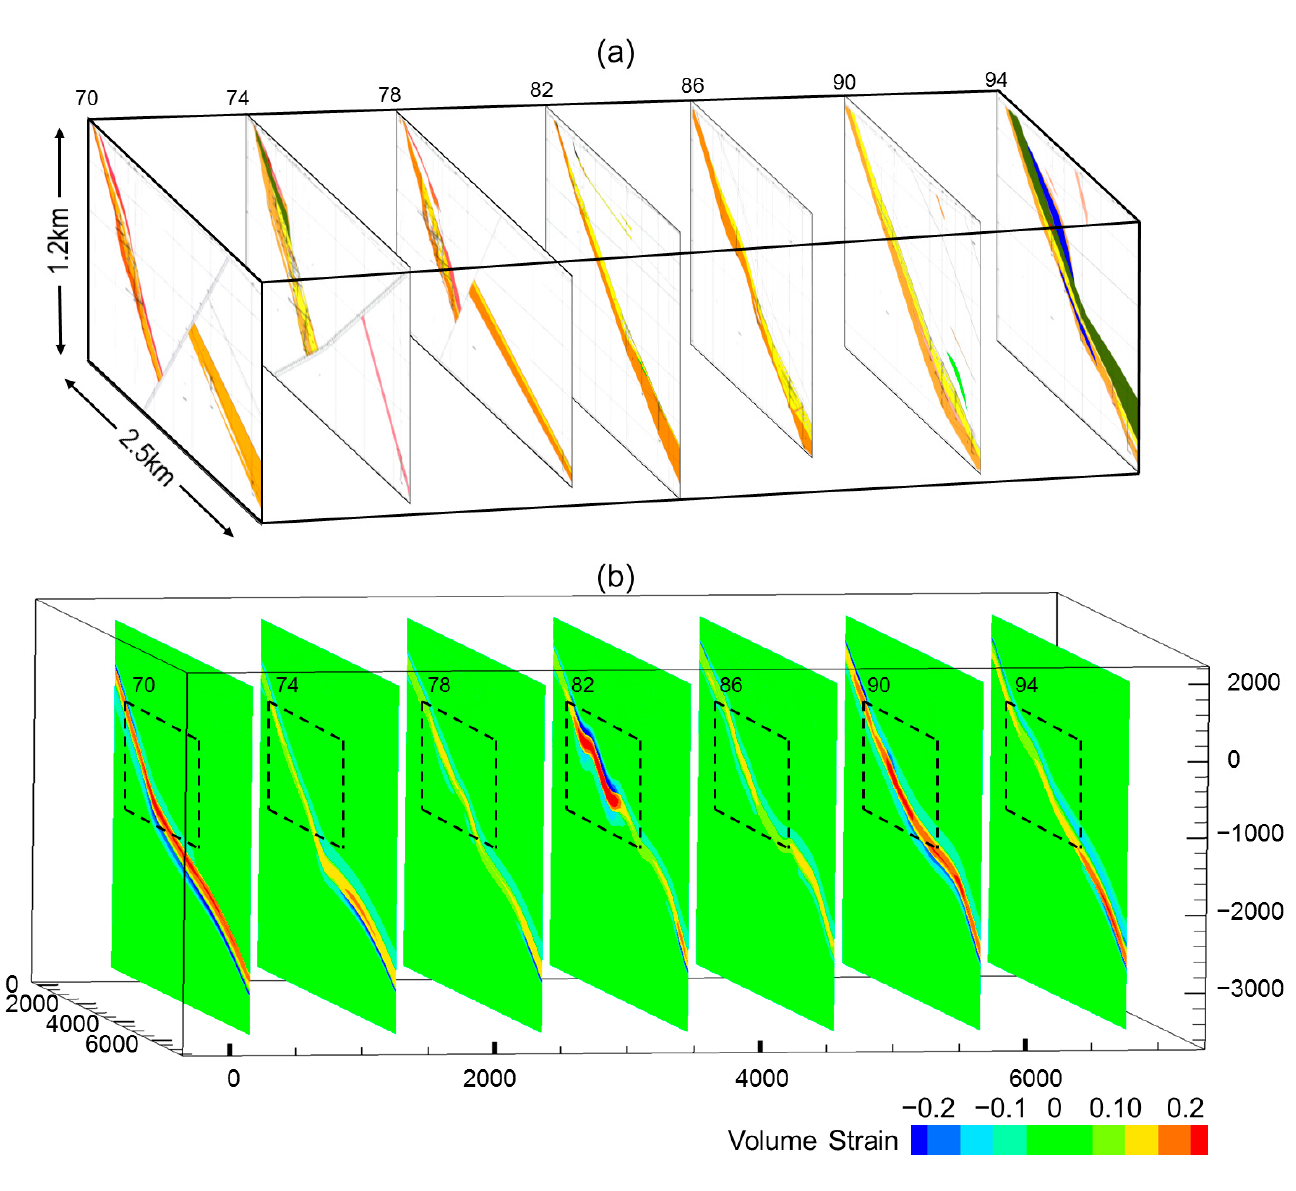
Figure 11. Cross-section of volume strain corresponding to exploration line with 1% bulk shortening. The rectangular box is the scope of the cross-sections. ( a ) Nos. 70~94 geological cross-sections; ( b ) cross-section of 1% bulk shortening in Model